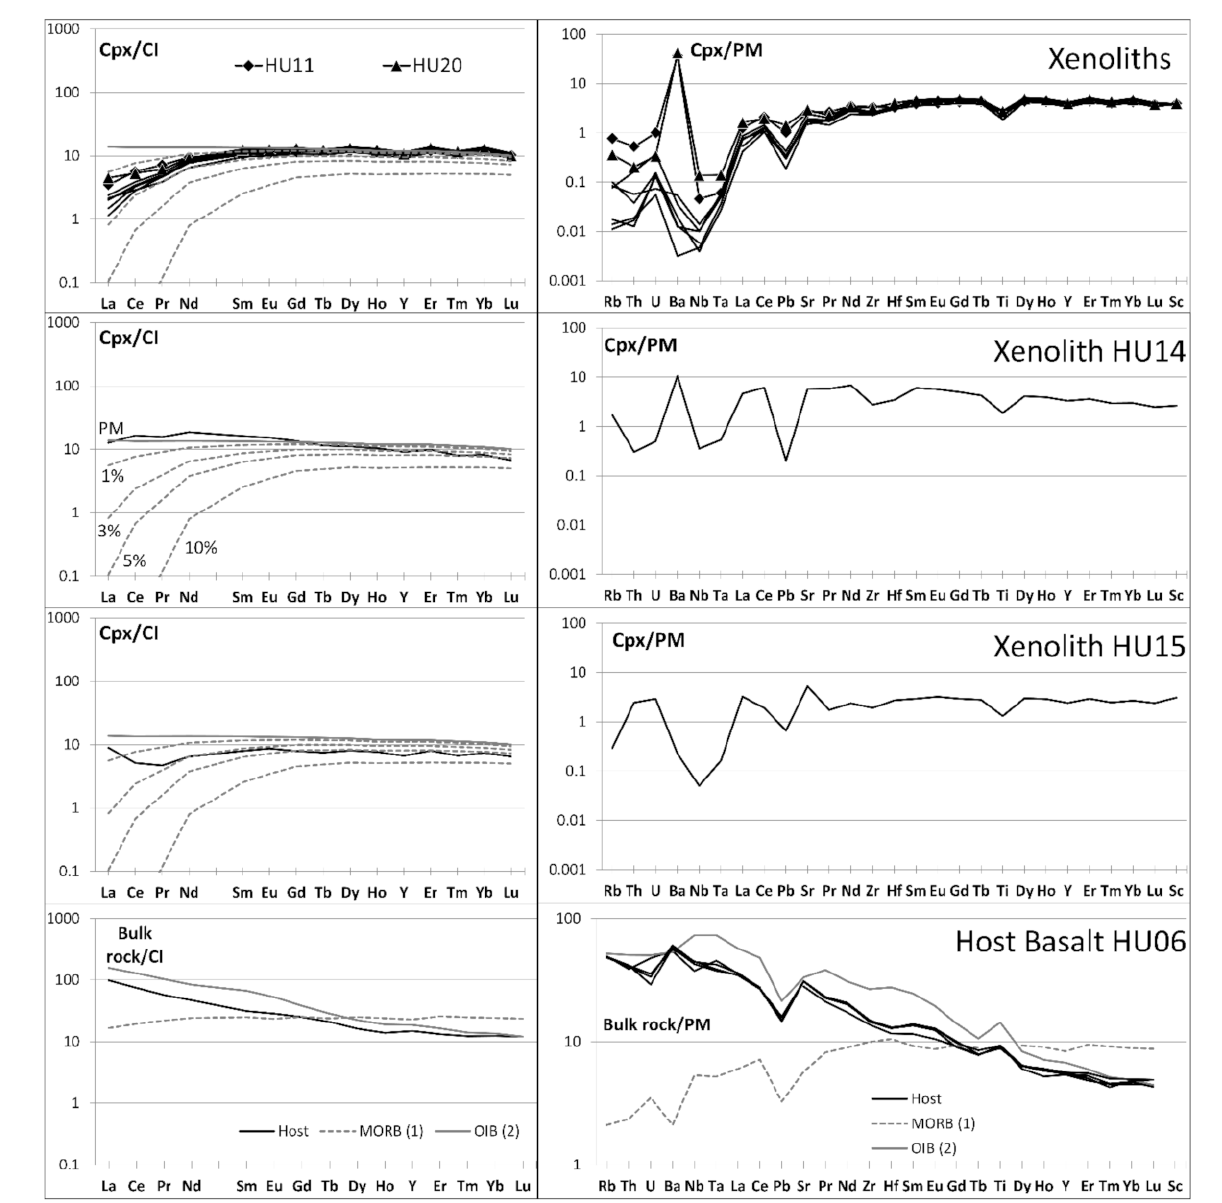
Figure 6. REE and trace elements spiderdiagrams of clinopyroxenes from Huanul mantle xenoliths and host basalt (sample HU06 from Bertotto et al. [41]). REE patterns are normalized to Chondrite-I values (CI) of Lyubetskaya and Korenaga [47]. Spiderdiagrams are normalized to the Primite Mantle (PM) values of McDonough and Sun [48]. The pattern of a primitive mantle-clinopyroxene (solid grey line) of Sun and McDonough [49] and patterns (dotted gray lines) after 1, 3, 5, and 10% of depletion by partial nonmodal melting are also shown. Pattern of MORB [50] and OIB [49] are reported for